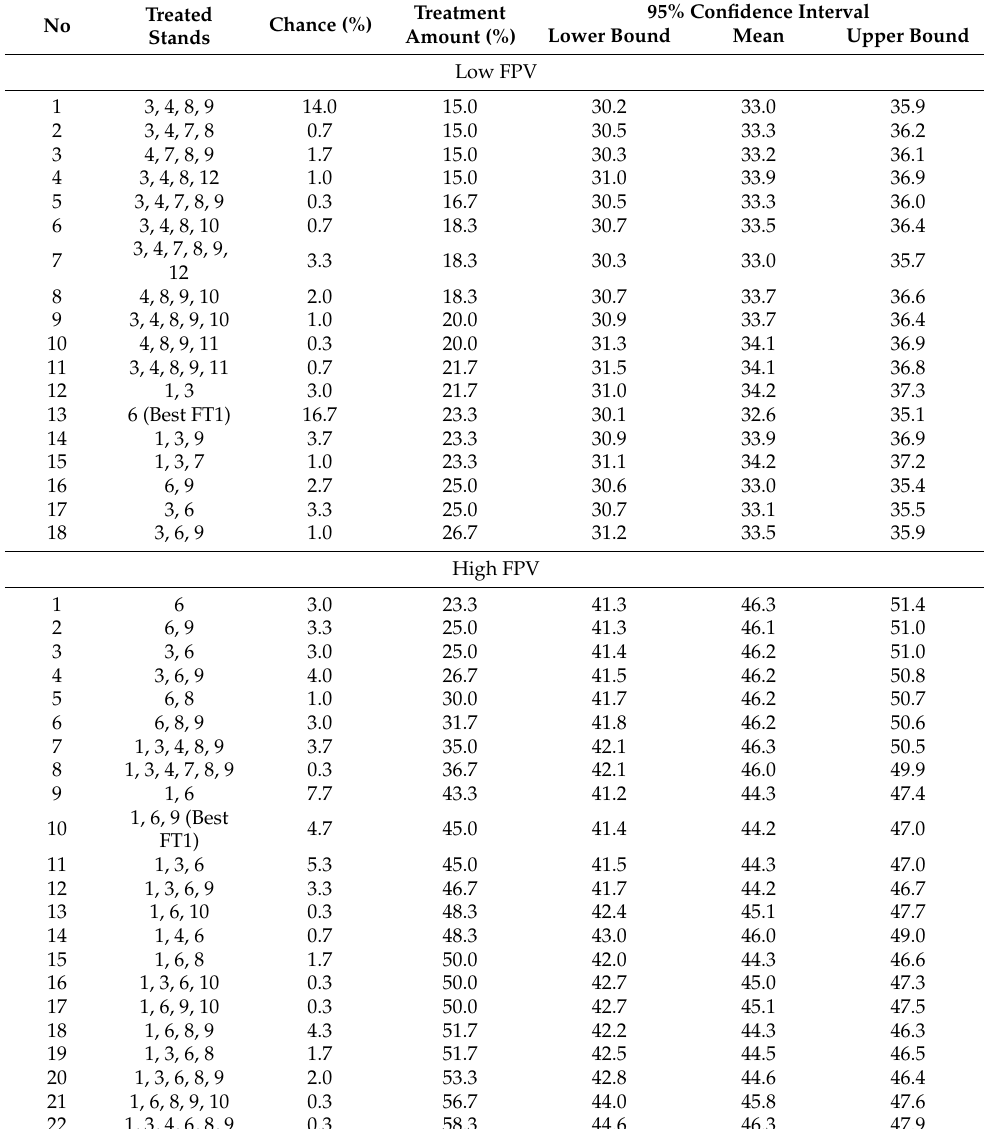
Table 3. The best and alternative FT1s under different forest protected value (FPV) assumptions. 95% Confidence Interval Treatment Treated Chance (%) No Lower Bound Mean Upper Amount (%) Stands